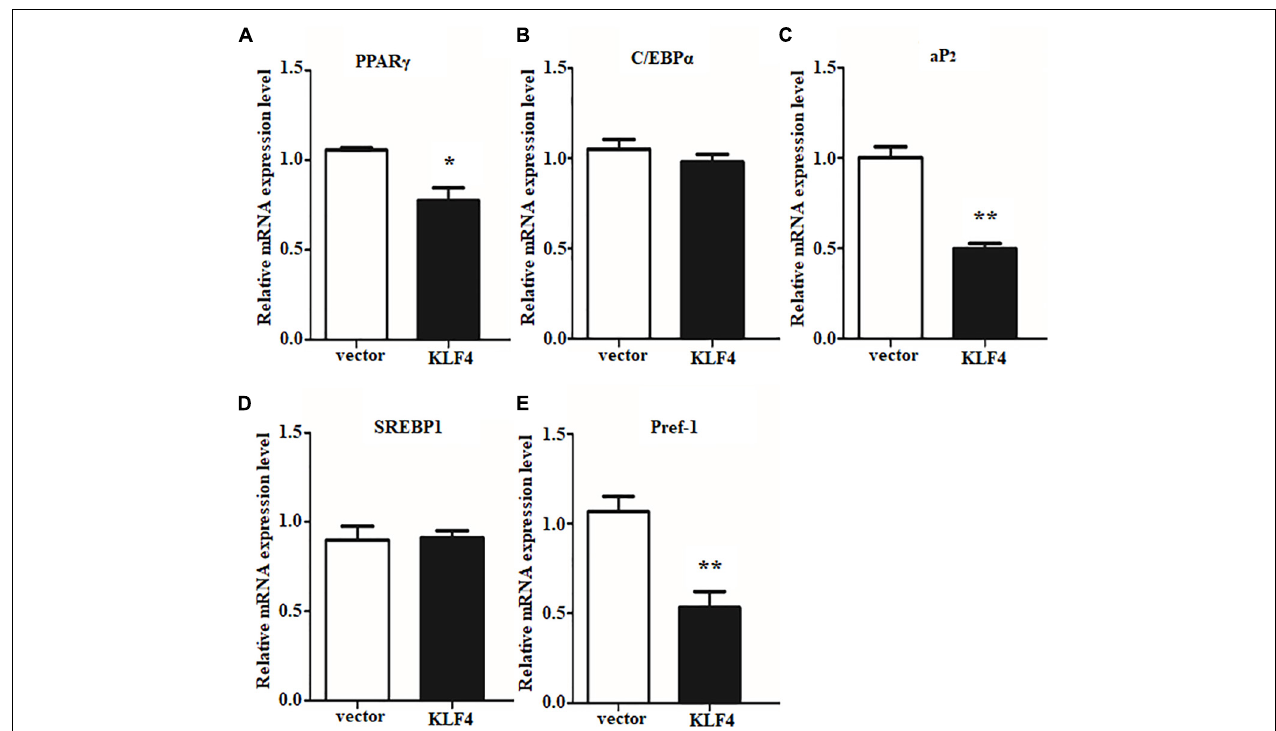
FIGURE 5 | Overexpression of KLF4 downregulates PPAR γ , aP2, and Pref1 expression. The mRNA levels of PPAR γ (A) , C/EBP α (B) , aP2 (C) , SREBP1 (D) , and Pref1 (E) in control and adenovirus-treated intramuscular adipocytes. * p < 0.05, ** p < 0.01 versus negative control (vector) groups. The data are presented as the mean values ± SD. Each experiment was performed at least in triplicate, producing consistent results. * p < 0.05, ** p < 0.01.